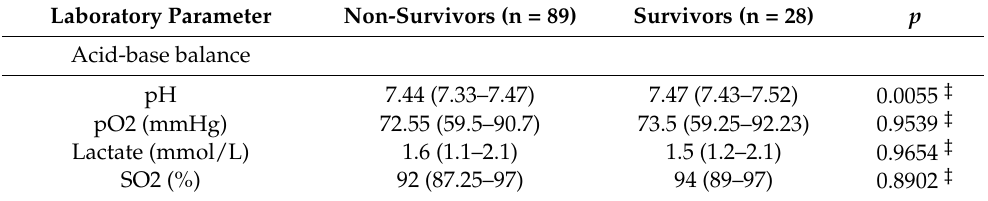
Table 4. Survival data analysis for critical COVID-19 patients. Laboratory Parameter